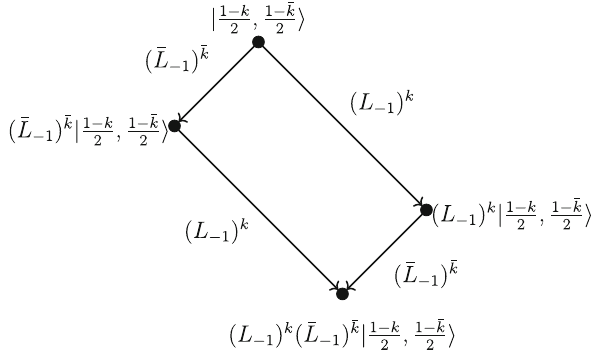
Fig. 3 Celestial Diamond illustrating the nested submodule structure of SL ( 2 , C ) primary descendants that exist for special values of the conformal